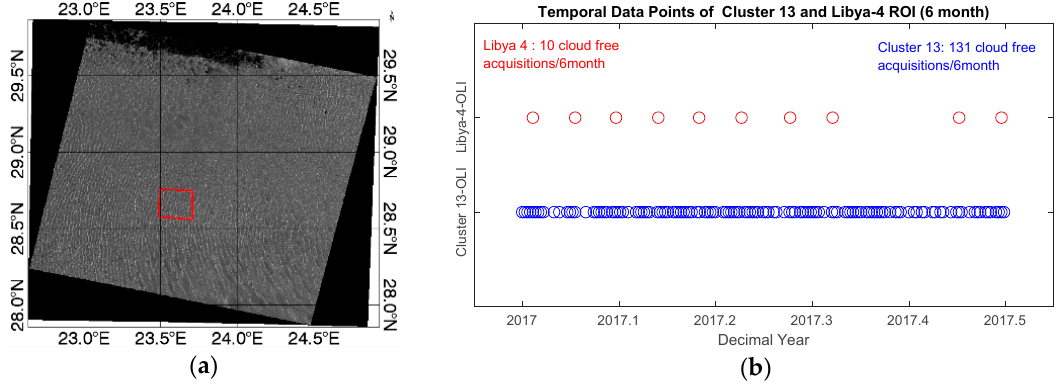
Figure 5. ( a ) Libya-4 CNES ROI (Red rectangle) over WRS-2 path-row 181/40 image from Landsat 8 (Left). ( b ) Improvement of temporal revisit period using EPICS over traditional Libya-4 PICS (Right).